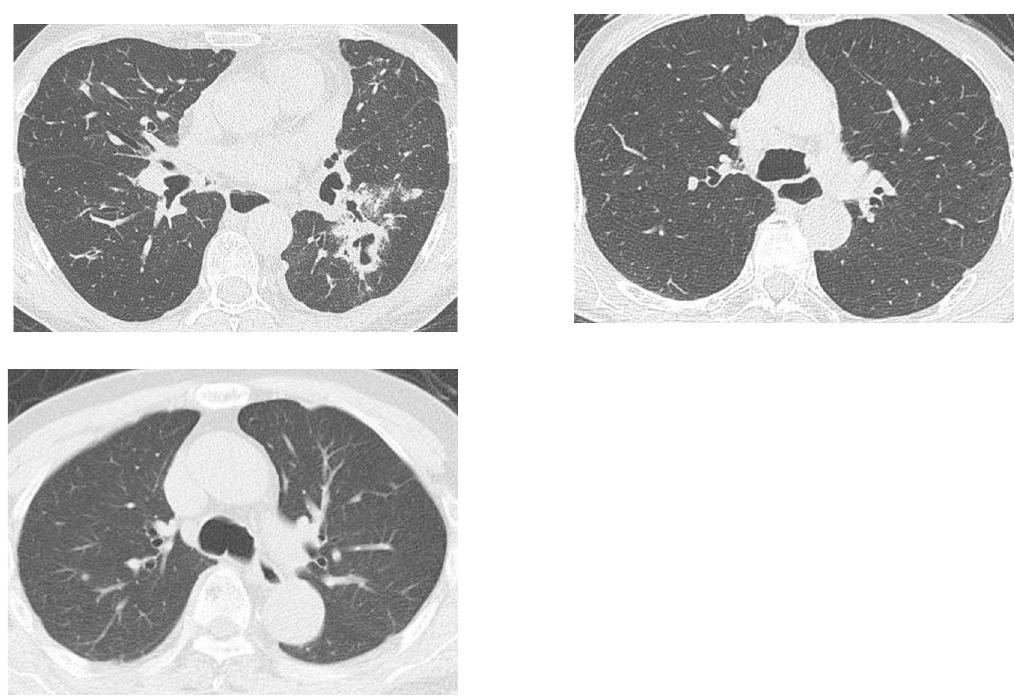
Fig 2. Typical cases of esophageal dilatation. CT images of three cases whose maximum diameter of esophagus is larger than 15mm were shown.